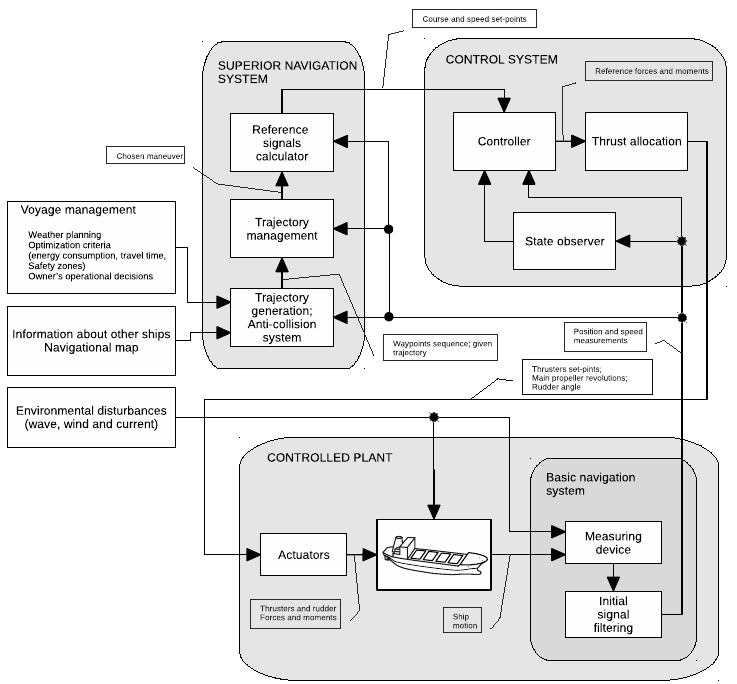
Figure 2. General arrangement of the automatic ship motion control